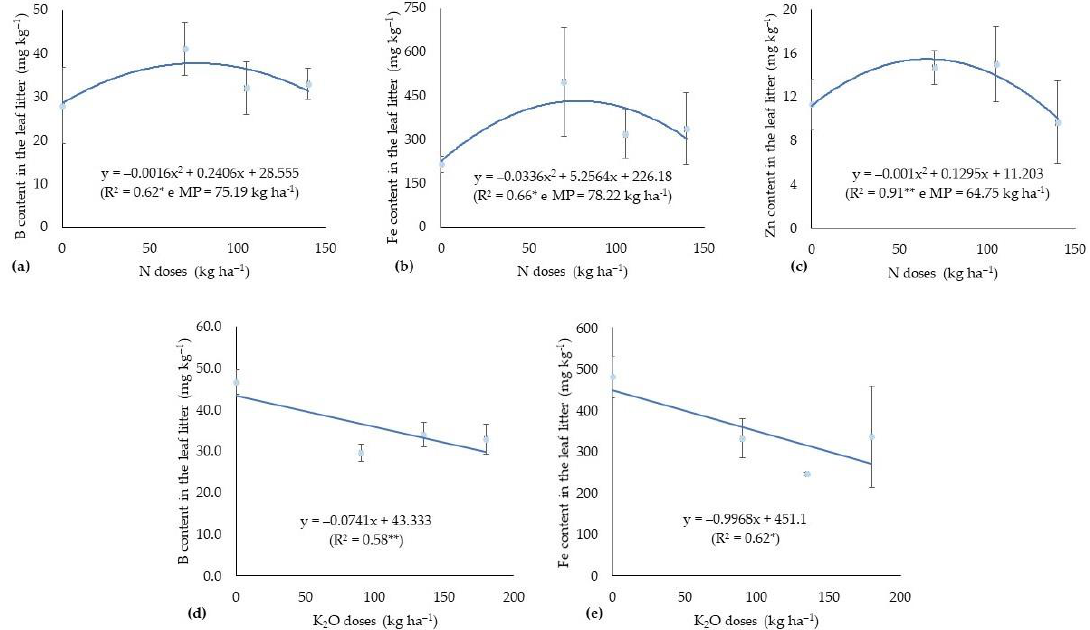
Figure 4. ( a ) Boron, ( b ) iron and ( c ) zinc content in eucalyptus leaf litter as a function of residual N dose. ( d ) Boron and ( e ) iron content in eucalyptus leaf litter as a function of residual K 2 O dose. Each point located on each graph is the mean of five replications. * and ** = significant at 5 and 1% level by F test, respectively.